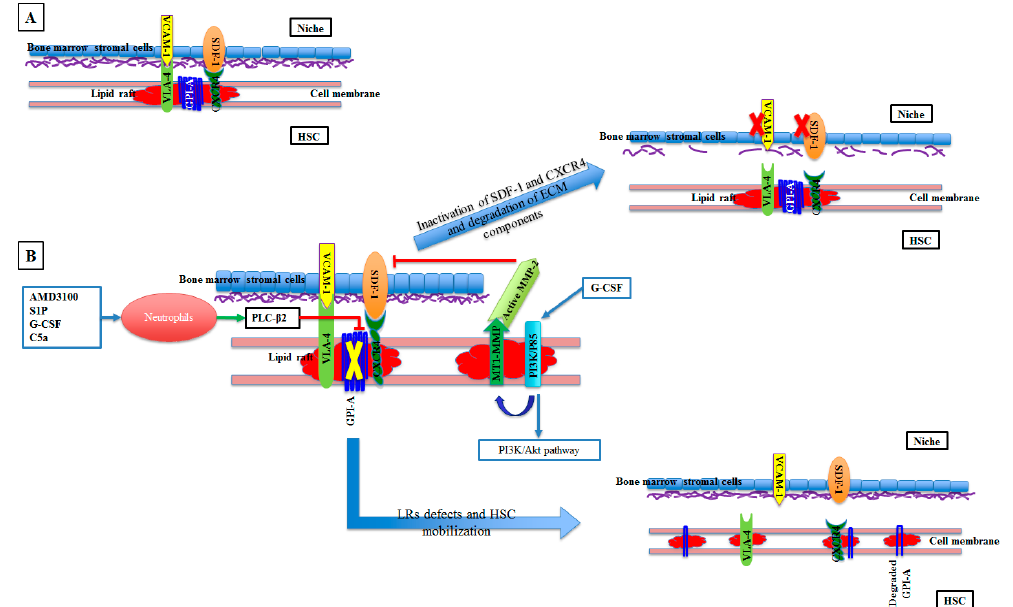
Figure 2. Role of LRs in HSC mobilization. A, Quiescent status of HSC in the niche: The LR incorporated proteins VAL-4 and CXCR4 of HSCs bind to VCAM-1 and SDF-1 proteins of the niche, resulting in HSC stabilization. B, Mobilization status of HSCs: premobilization factors found in the niche, such as AMD3100, S1P, G-CSF, and C5a, enhance the expression of PLC- β 2 of neutrophils. PLC- β 2 cleaves GPI-A in the LRs, resulting in disruption of LRs and associated proteins VLA-4 and CXCR4, leading to the detachment of SDF-1 and VCAM-1 ligands and HSC mobilization. In addition, G-CSF activates PI3K/P85 located in the LRs of HSCs, leading to activation of the PI3K/Akt pathway and incorporation of MT1-MMP into the LR, activating MMP-2 at the cell surface. MMP-2 then modulates the matrix, inactivating SDF-1 and CXCR4 and enhancing pericellular degradation of the ECM components. These changes result in the release of HSCs from the bone marrow niches.